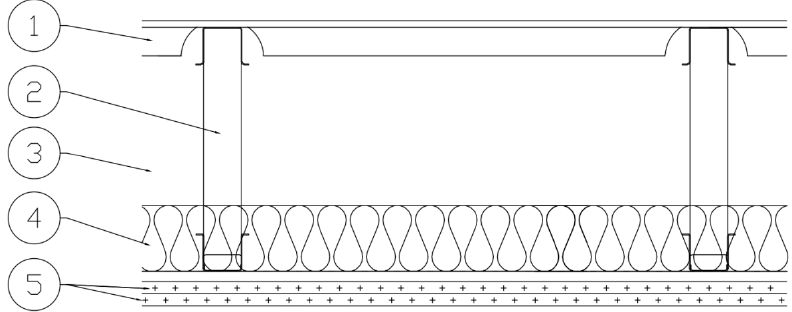
Figure 4. Cross-section of a metal frame floor (1—profiled sheet, 2—steel trusses, 3—air gap, 4—glass wool, 5—plaster board). Table 1. Sound absorption coefficients, α p , of used materials, in octave bands.